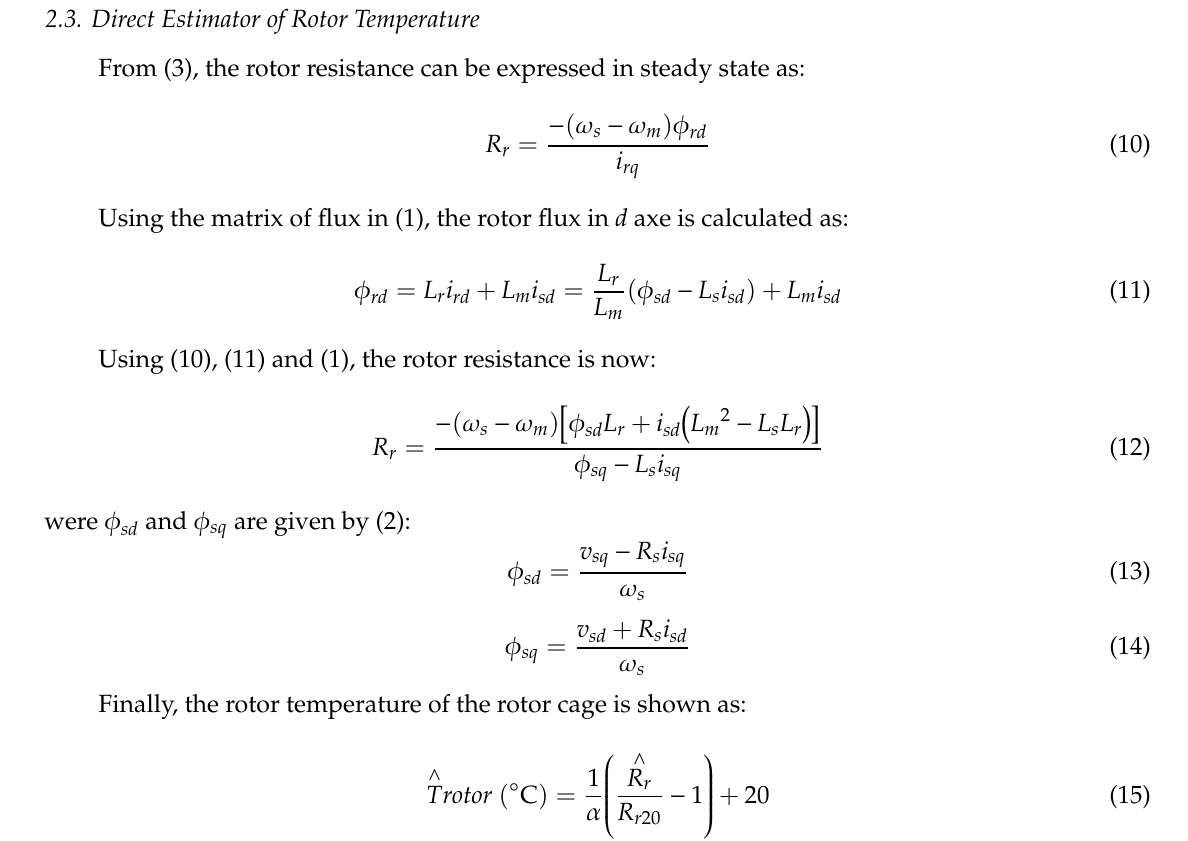
Figure 1. The 30 kW operating point with slip compensation using infrared pyrometer for measurement of rotor cage temperature.